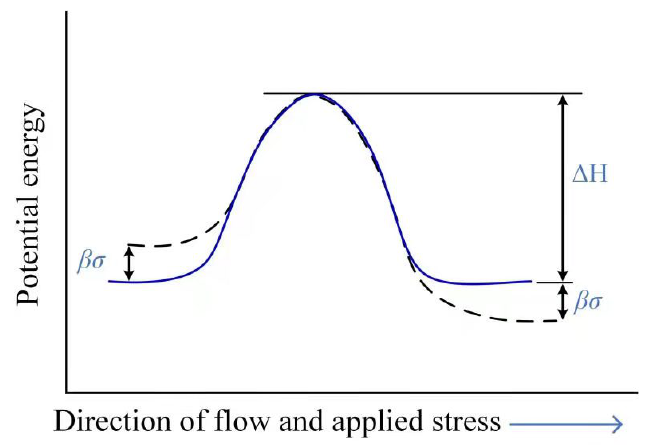
Figure 26. A schematic representation of the Eyring